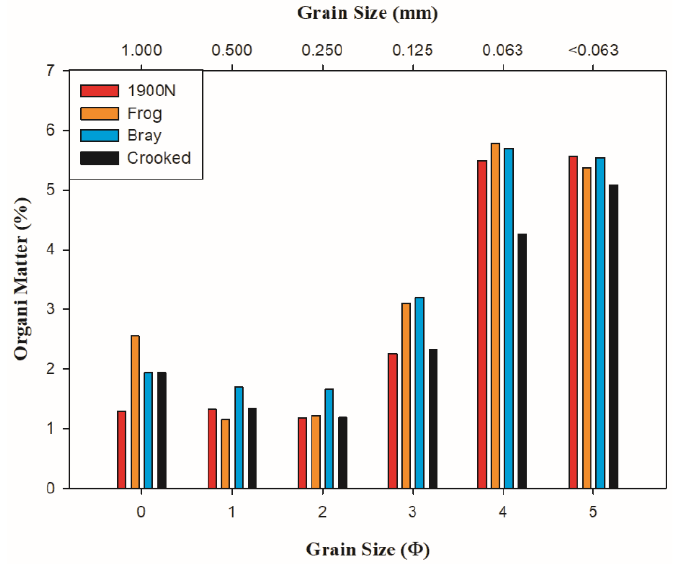
Figure 8. Cumulative percent organic matter in sediment less than 1 mm in diameter collected during the fall and spring.